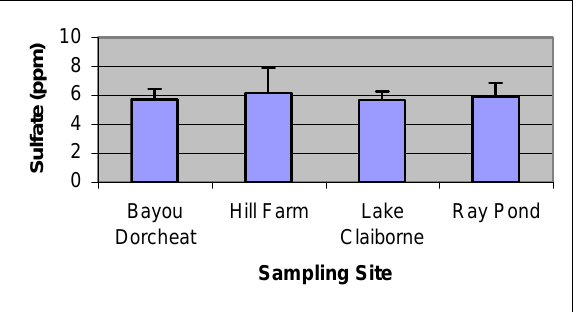
Figure 10: Mean (n=15) values of sulfate (ppm) levels at each sampling site